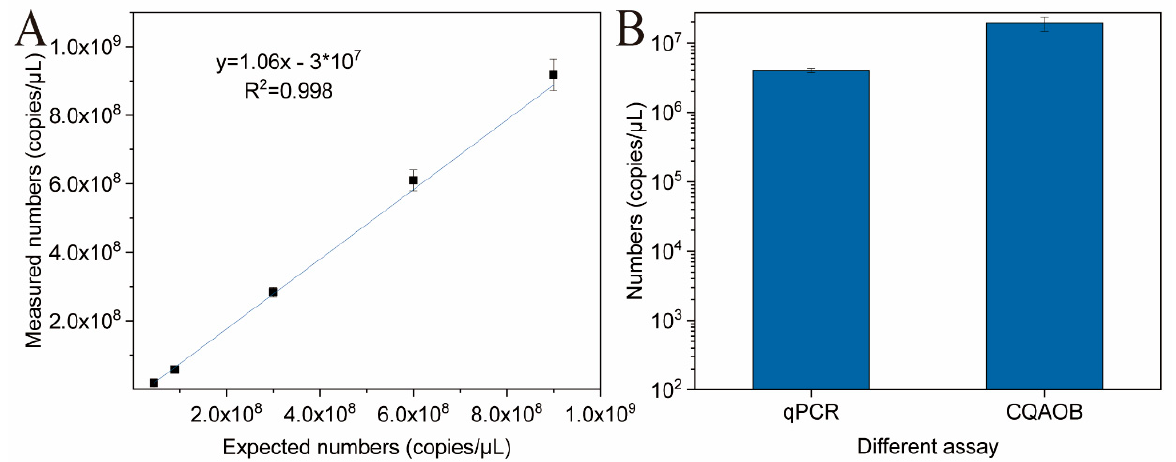
Figure 5. Consistency curve for the CQAOB detection system and simple quantification. ( A ) Consistency curve for CQAOB. The expected values are 9 × 10 8 , 6 × 10 8 , 3 × 10 8 , 9 × 10 7 , and 4.5 × 10 7 copies/ µ L. ( B ) Comparison of L. panis quantification in fermented grains samples using qPCR and